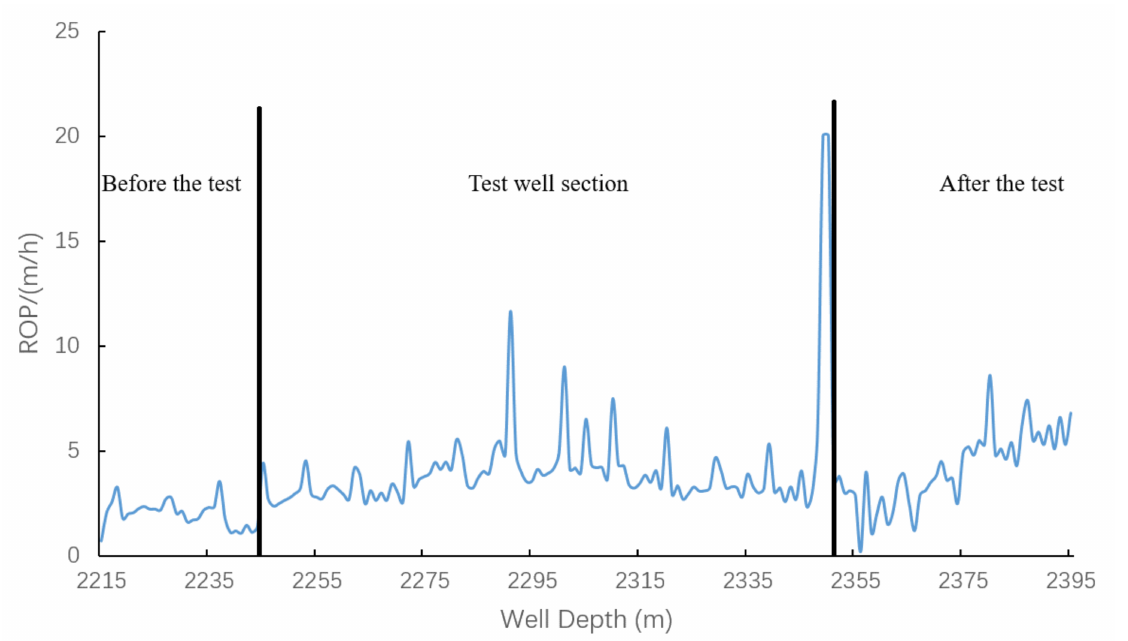
Figure 4. Drilling records of WWYl section (2244–2350 m) using drill string absorption & hydraulic supercharging & speed-up technology. Table 2. ROP and drilling